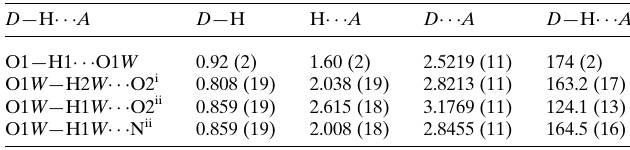
Table 1 Hydrogen-bond geometry (A˚ , (cid:3) ).